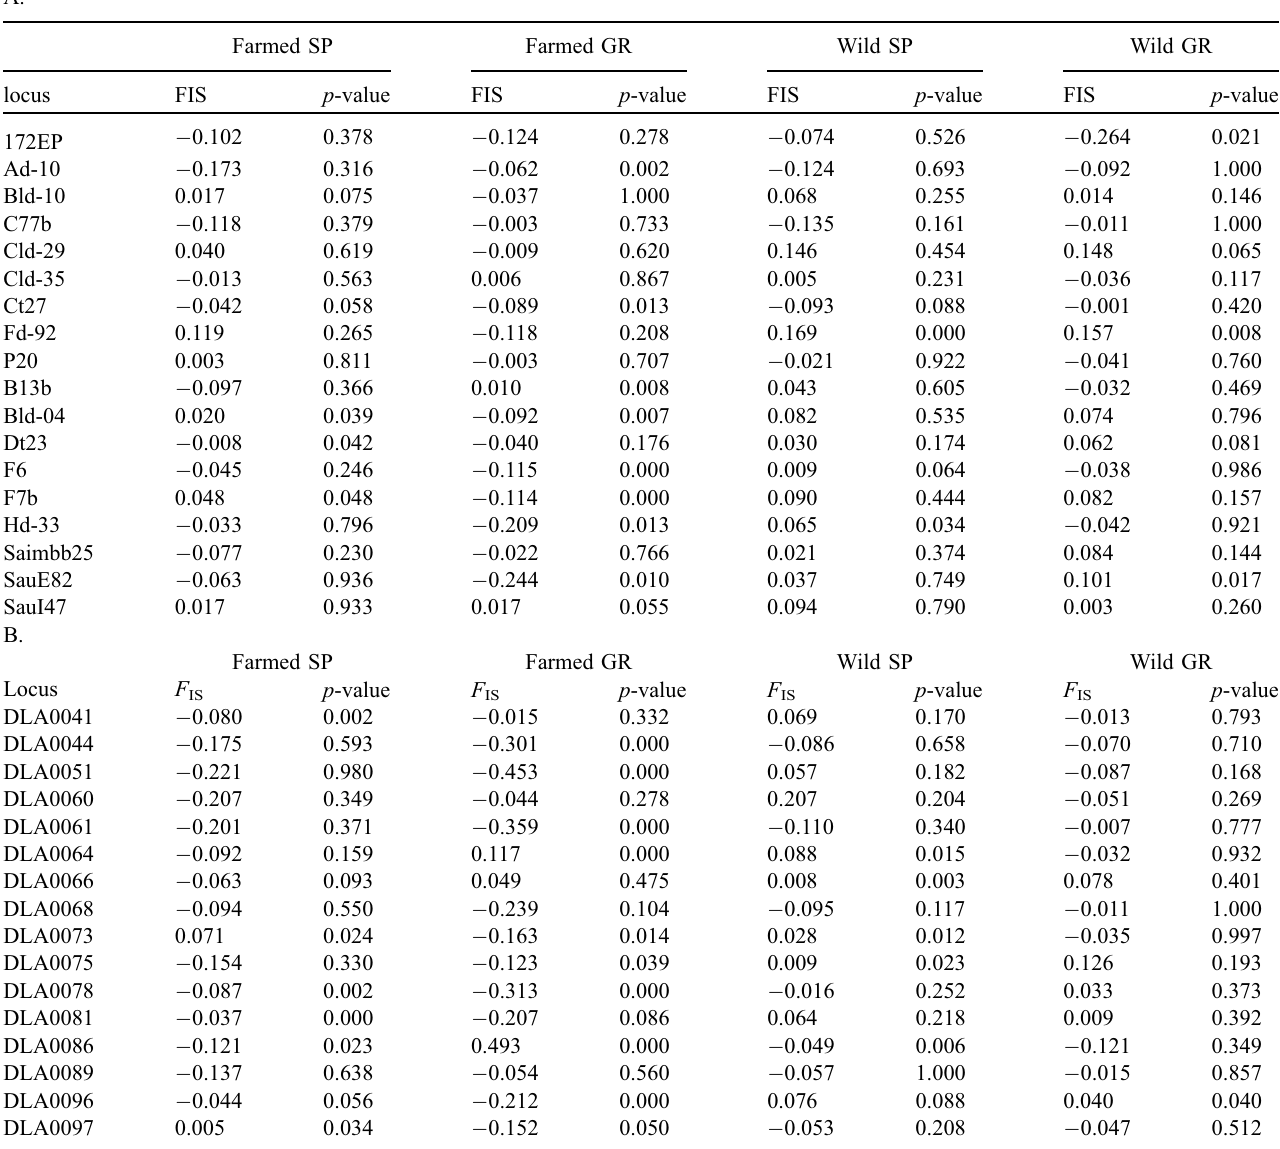
Table 2. F IS for S. aurata (A) and D. labrax (B) A.